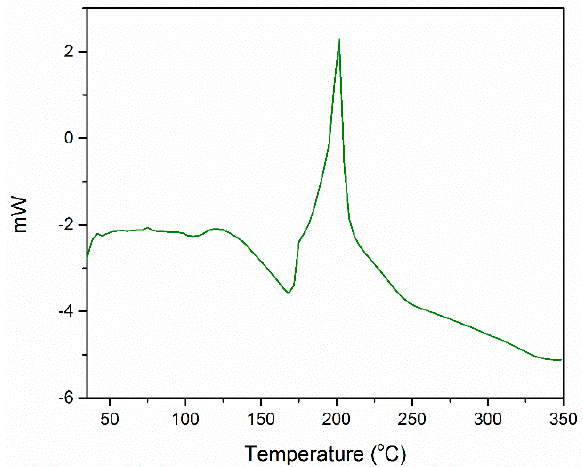
Figure 8. The DSC curve of esomeprazole magnesium water/1-butanol solvate. The curve was obtained from 25 to 350 °C at a heating rate of 5 °C/min. An exotherm characteristic of esomeprazole magnesium is seen at 200 °C as well as an endotherm at 175 °C.